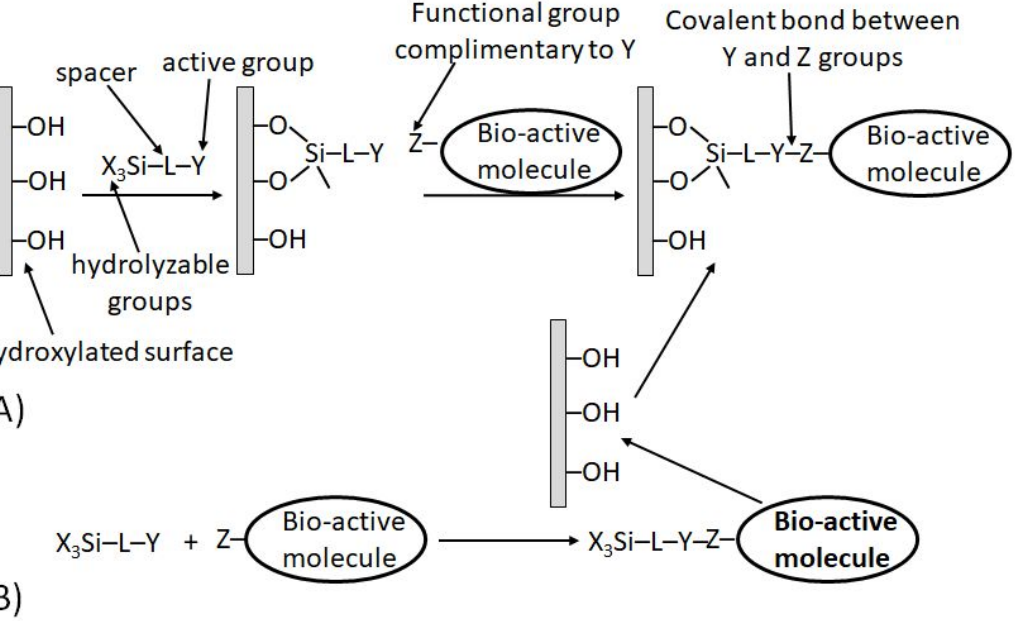
Figure 12. ( A )Immobilizationofabioactivemoleculeontoasilane-derivatizedsubstrate. ( B ) Immobilization Figure 12. ( A ) Immobilization of a bioactive molecule onto a silane ‐ derivatized substrate. ( B ) Im ‐ of a silane-derivatized bioactive mobilization of a silane ‐ derivatized bioactive molecule.